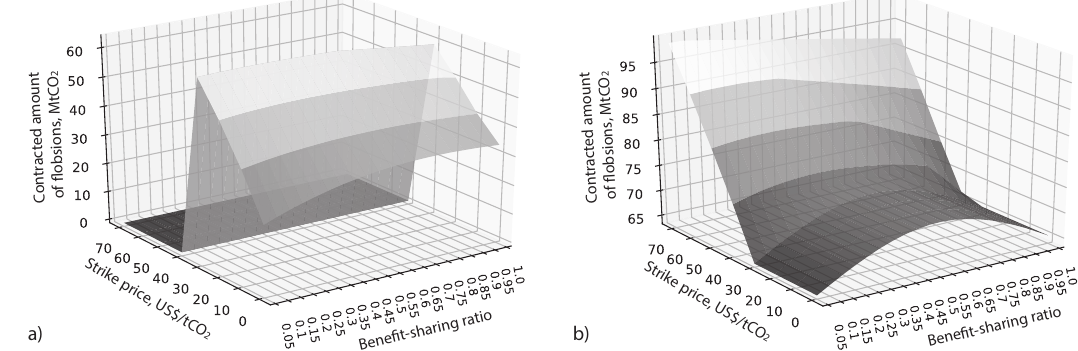
Figure 8. Contracted amounts of flobsions with respect to benefit-sharing ratio, δ ∈ [ 0.05,1 ] and